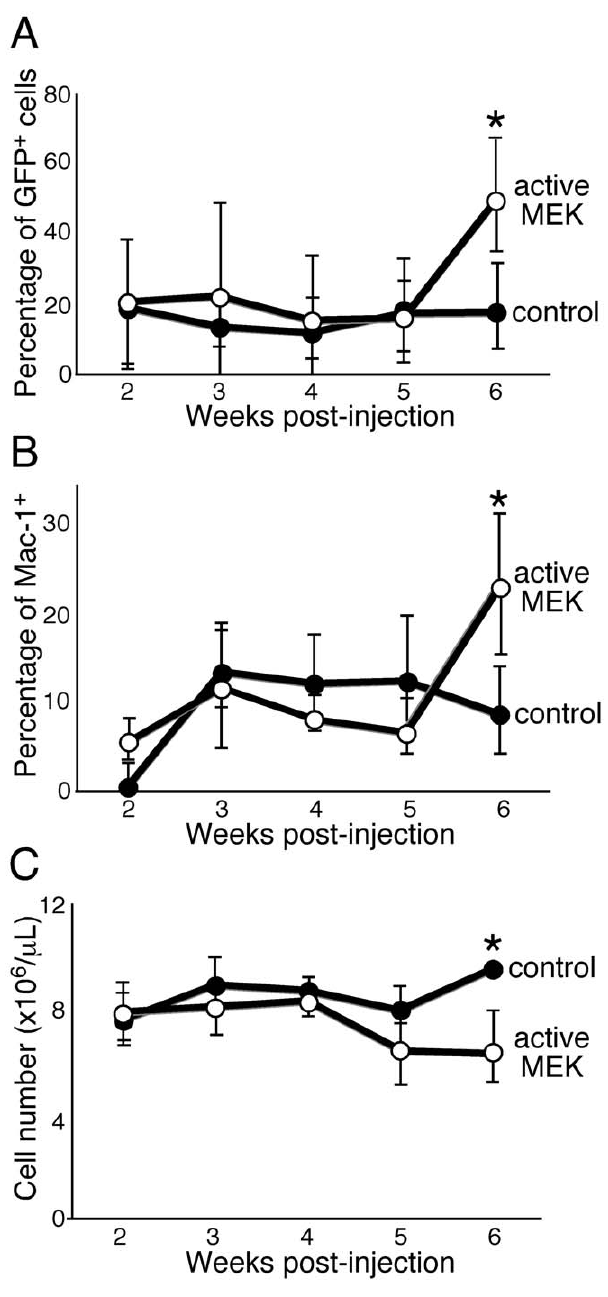
Figure 3. Invivo time course analysis of peripheral blood. (A, B) Peripheral blood was collected from vector control (filled circle, n=3) or active MEK mice (empty circle, n=5) two weeks post-injection and then weekly, thereafter. Cells were stained with antibodies and subjected to FACS analysis. Cells were pre-gated on GFP + cells and dead cells were excluded from the analysis by PI staining. (C) Differential cell counting was performed on peripheral blood harvested from control mice (filled circle) and active MEK mice (empty circle) using a HemaVet machine to assess red blood cell number. Data shown are the mean values from all mice in each group. Error bars represent the standard deviation from each group of mice. *, P , 0.05 (statistical significance) by Student t test.